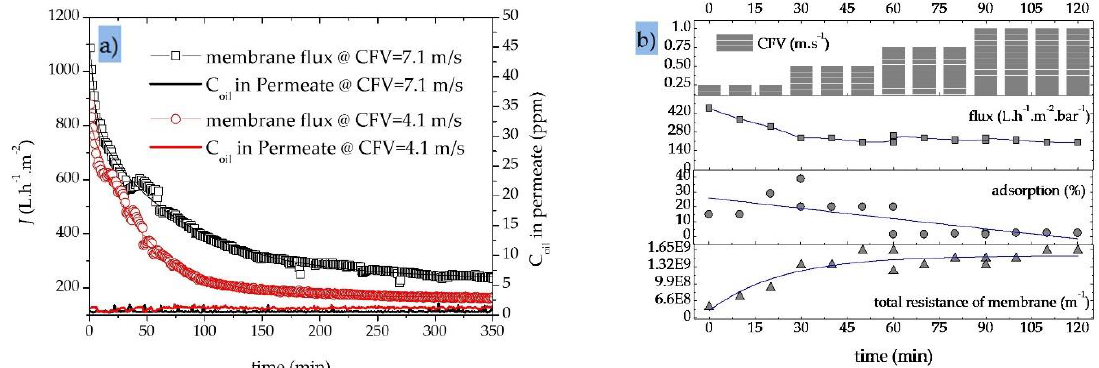
Figure 7. Variations in the permeate flux under different conditions. ( a ) Variations in permeate flux with time for a SiC UF membrane (40 nm) at different crossflow velocities (CFVs) (4.1 and 7.1 m·s − 1 ) and the corresponding oil content in permeate samples; transmembrane pressure (TMP) = 2.0 bar; fed-batch mode; OMS initial oil concentration = 30 ppm; T = 50 °C. ( b ) Variations in permeate flux, oil adsorption/desorption and total residence of the membrane with time for a SiC MF membrane (200 nm); CFV = 0.25, 0.5, 0.75 and 1.0 m·s − 1 ; initial oil concentration = 200 ppm; total recycle mode; T = 40 °C, TMP = 1 bar.